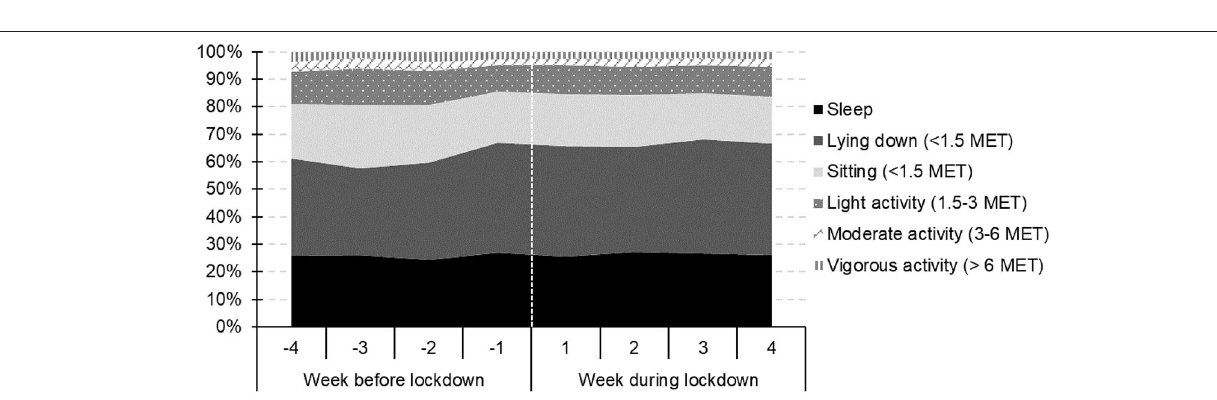
FIGURE 2 | The proportional duration of sleep, lying down and sitting, and physical activities other than training during the 4-week periods immediately before and after the start of the lockdown (MET = metabolic equivalent of